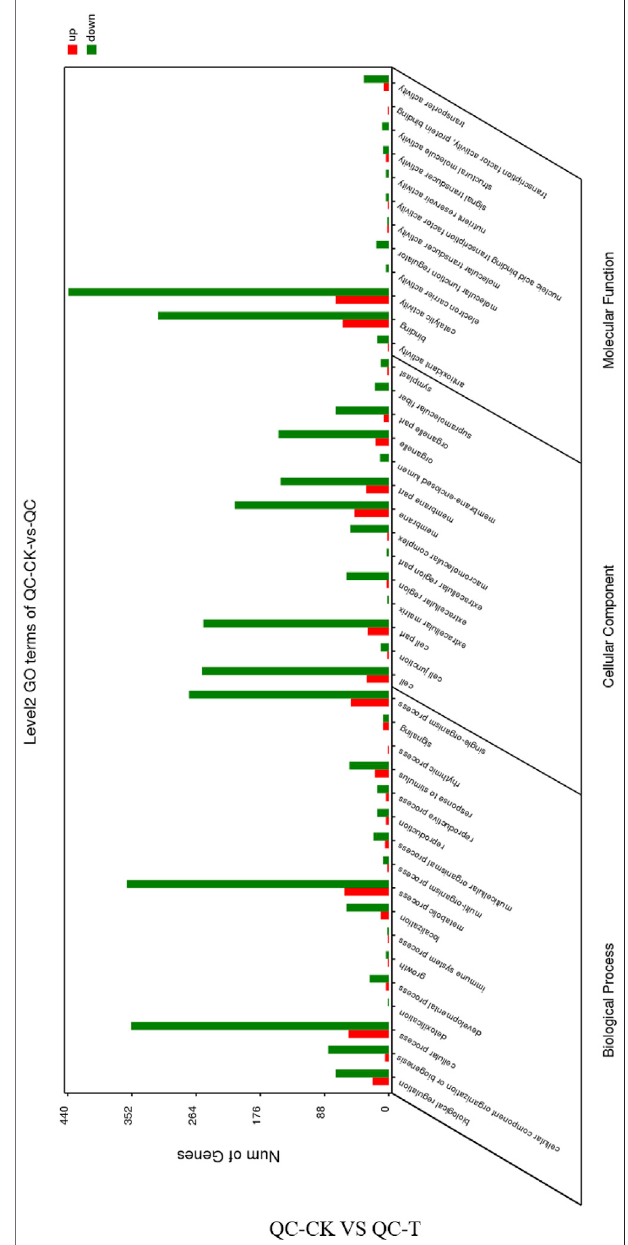
FIGURE 4| GO function annotation ofthe differentially expressed genes in QC tea plantation. QC, Cutting tea plant. CK: Cutting samples treated with drought for 0 days, T: Cutting samples treated with drought for 20